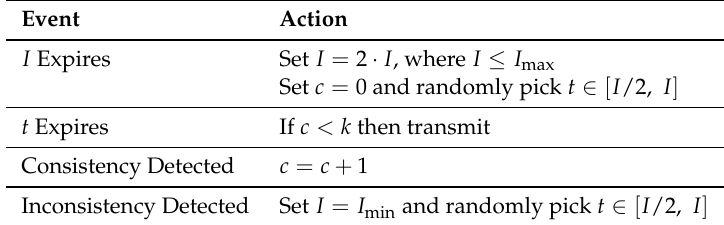
Table 2. Operations of the Trickle Algorithm